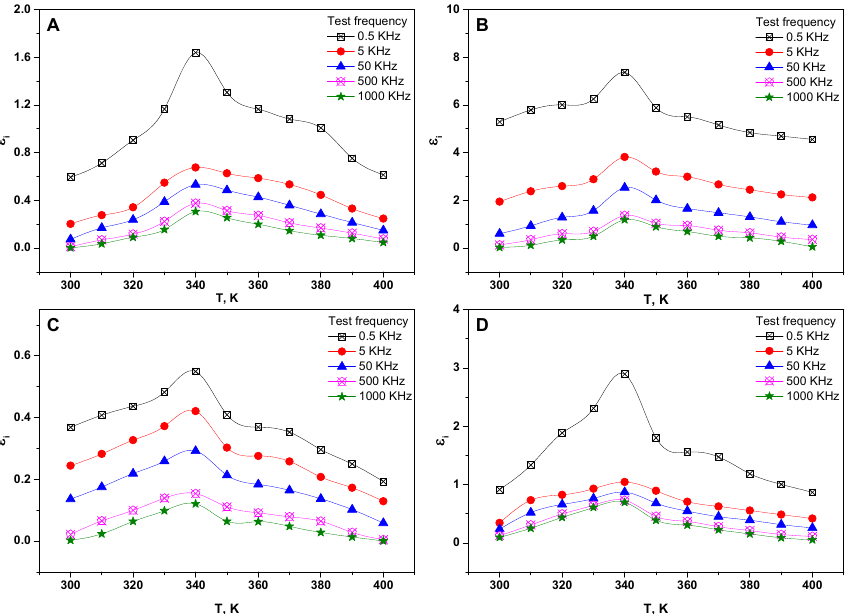
Figure 3 . Temperature and frequency dependence on imaginary dielectric constant for ( A ) poly(EDMA), ( B ) Pd(OAc) 2 /poly(EDMA)-5.1%, ( C ) poly(EDMA-co-MMA), ( D ) and Pd(OAc) 2 /poly(EDMA-co-MMA)-1.6%.